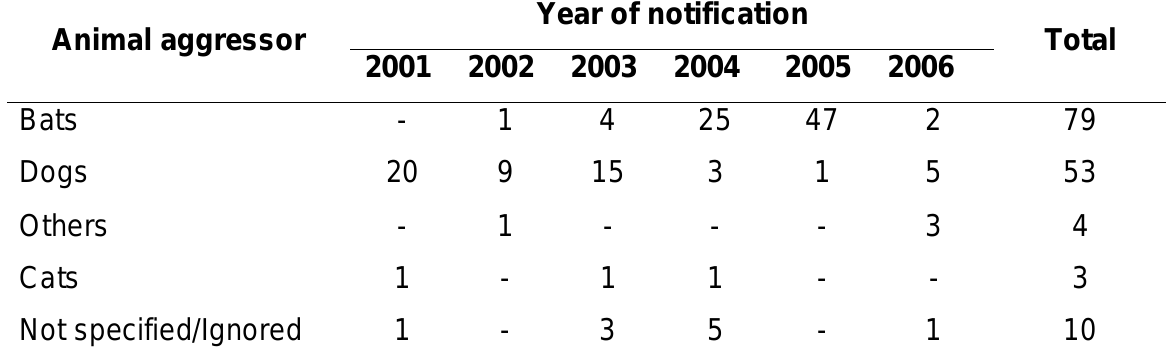
Table 1. Cases of human rabies notified in Brazil, from 2001 to 2006, according to the animal